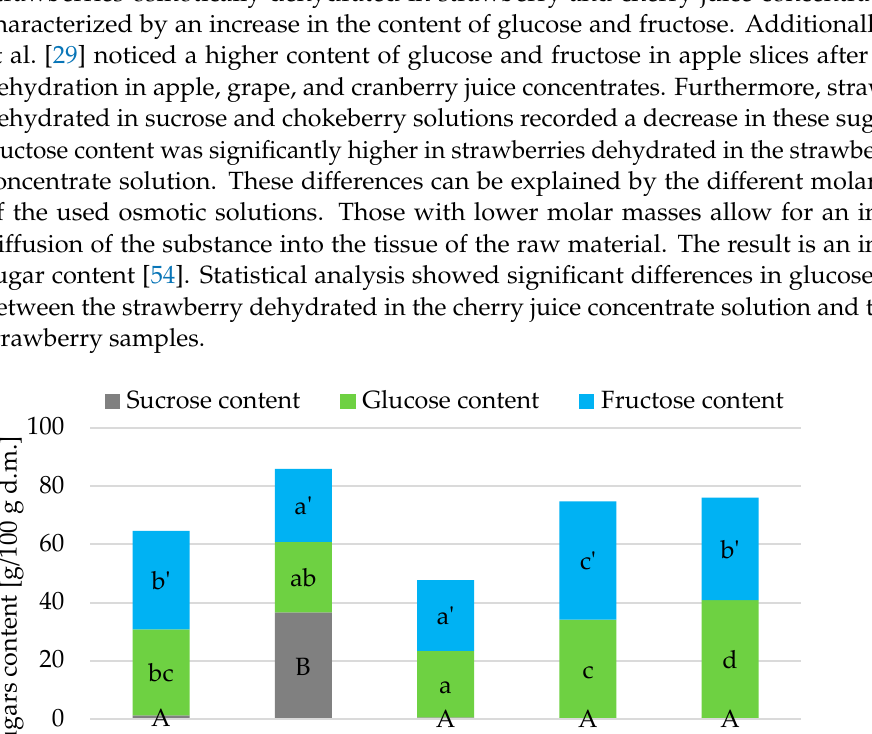
Figure 10. Effect of the type of osmotic agent (sucrose and fruit concentrates) on the sugar content in osmodehydrated strawberries.